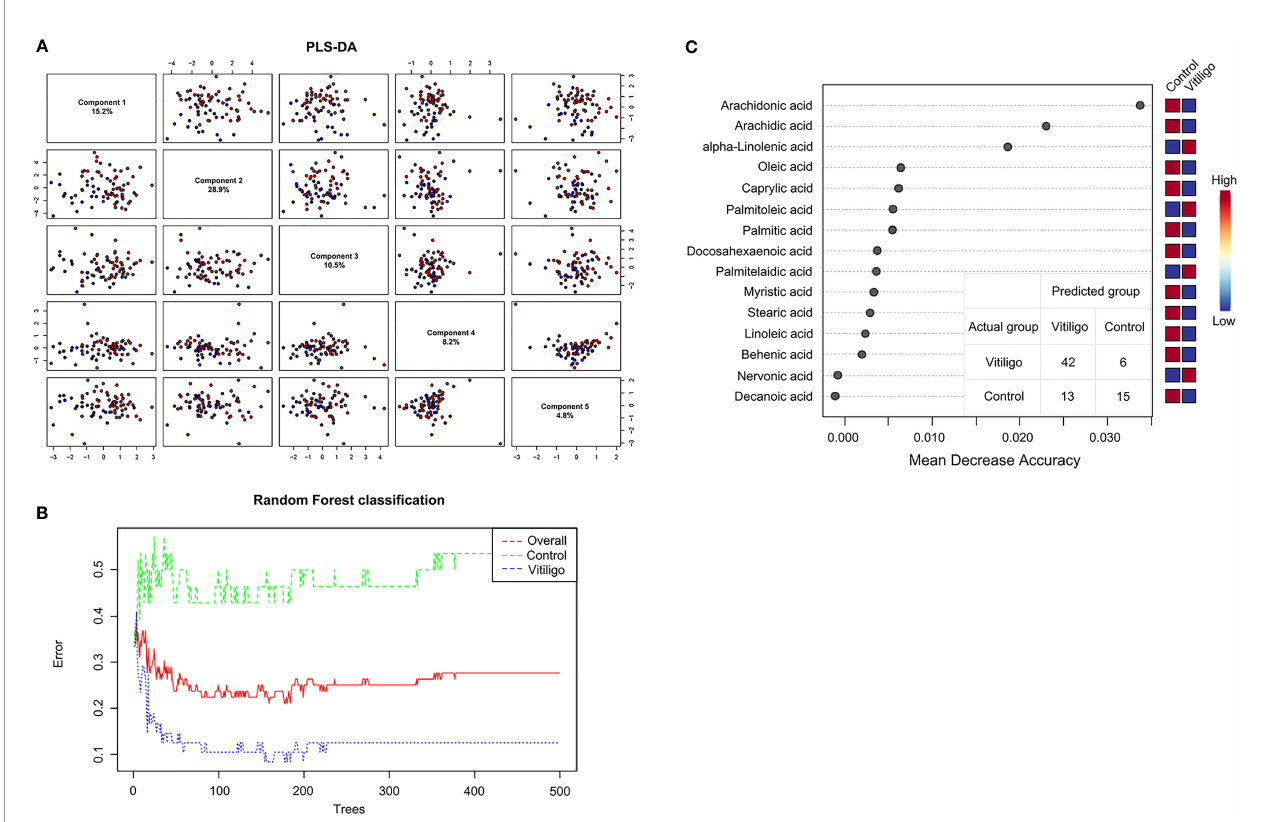
FIGURE 1 | Utilization of fatty acid pro fi les for classi fi cation of vitiligo patients and healthy controls by PLS-DA and RF analysis. (A) PLS-DA model shown the fi ve principal components with the relative variances in pairwise scores plots. (B) Cumulative error rates by RF Classi fi cation. The red line represents the overall error rate; the vitiligo error rate and control error rate is shown as the blue line and green line, respectively. (C) Signi fi cant features con fi rmed by RF. The features are ranked by the mean decrease in classi fi cation accuracy when they are permuted. PLS-DA, partial least squares discriminant analysis; RF, random